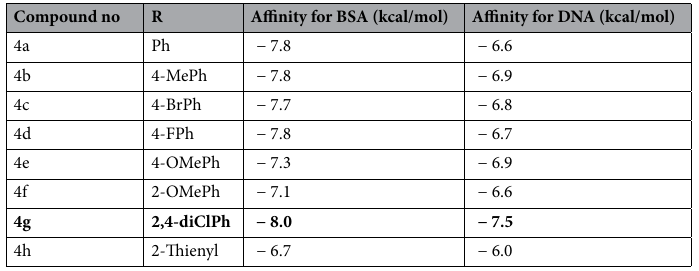
Table 5. Binding affinities of thiazolo[3,2- a ]pyrimidine derivatives 4a–h for DNA/BSA.